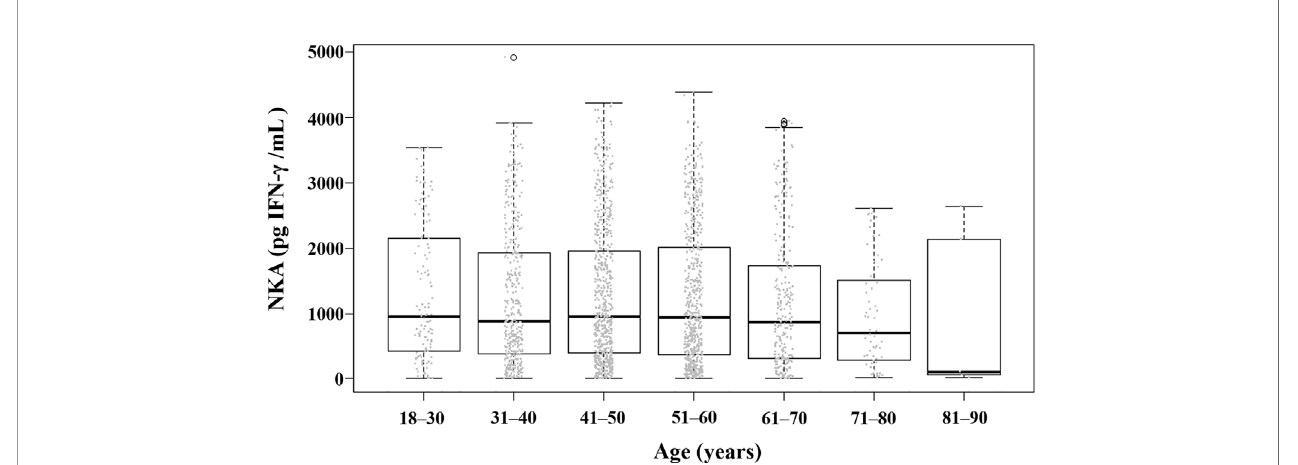
FIGURE 2 | Distribution of NKA value according to age. Each dot represents the individual value of NKA. Box plots show group medians, interquartile range (IQR), and spread of data with outliers for each group. NKA, natural killer cell activity.